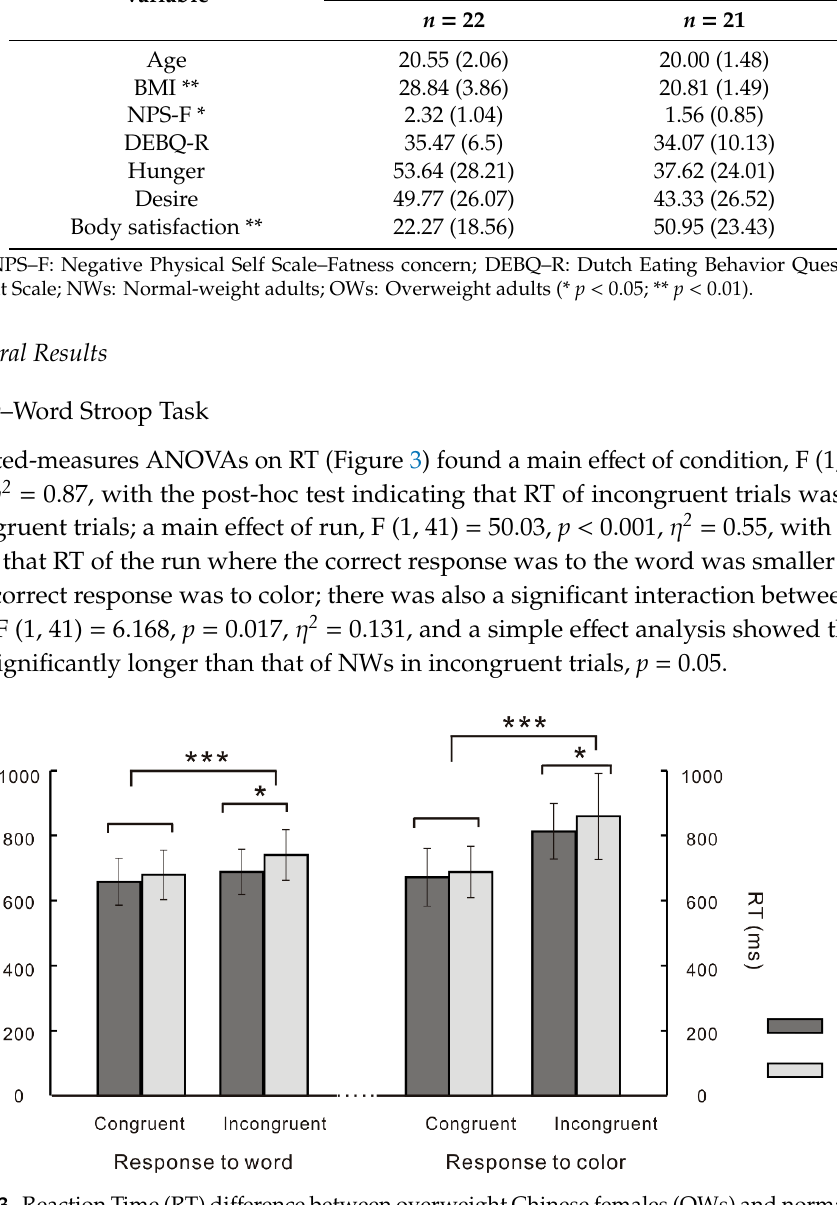
Figure 3. Reaction Time (RT) difference between overweight Chinese females (OWs) and normal-weight Chinese females (NWs) in the color–word Stroop task (* p < 0.05; *** p <